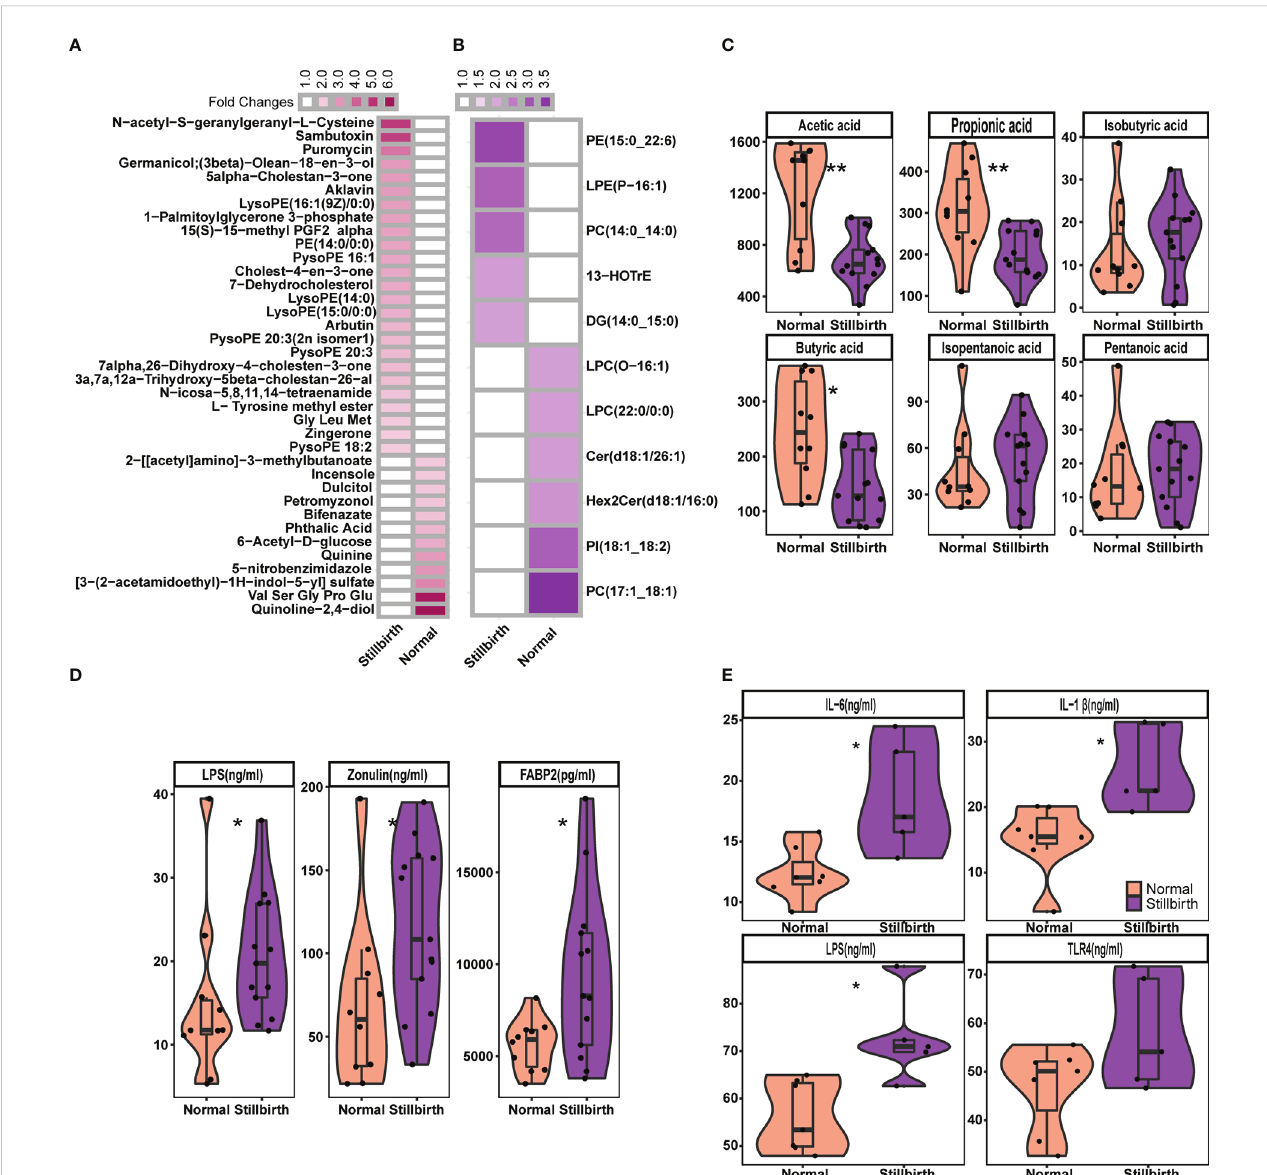
FIGURE 6 Comparison of the concentration of fecal metabolites, and serum cytokines and biomarkers between stillbirth and normal sow group. The differetial fecal metabolites between stillbirth and normal sow group at the threshold of VIP value > 1.5, wilcox test FDR < 0.05, and fold changes > 2. (A) widely targeted metabolome, and (B) lipidomic metabolites. (C) Comparision of the concentration of fecal SCFAs between stillbirth and normal sow group. (D) Comparison of the concentration of serum Lipopolysaccharide (LPS), zonulin and FABP2 in serum samples of DN1 cohort. (E) Comparision of the concentration of Lipopolysaccharide (LPS), IL-1 b , IL-6 and TLR4 in serum samples from the DN2 cohort. The stars indicate the signi fi cance thresholds: * FDR < 0.05 and ** FDR < 0.01 by Wilcoxon rank-sum